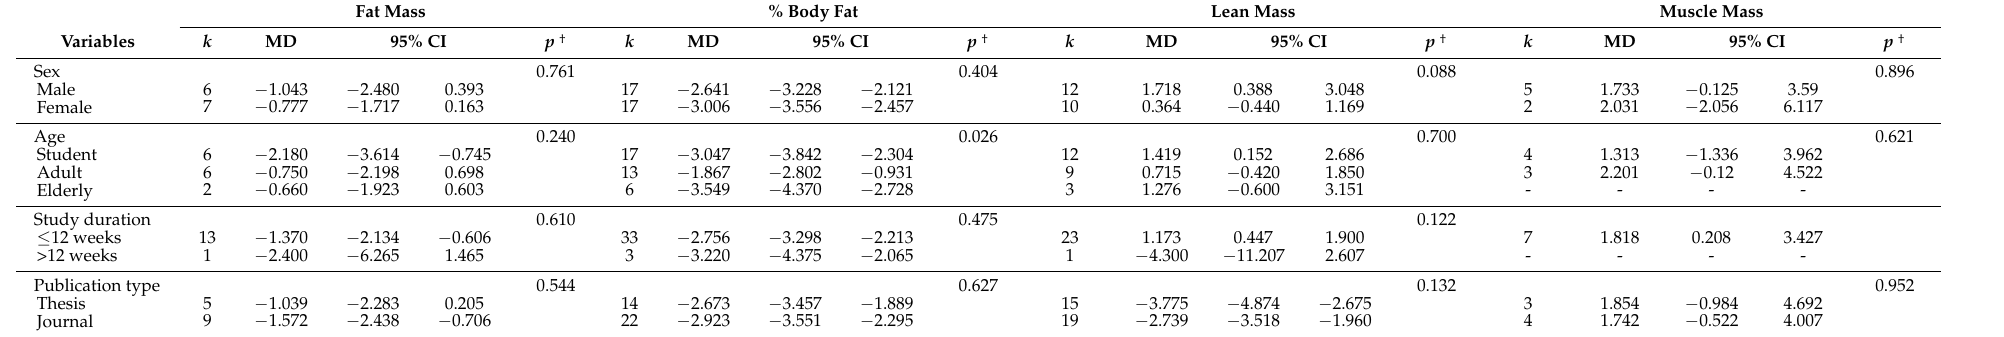
Table 3. Effects of moderators on fat mass, % fat, lean mass, muscle